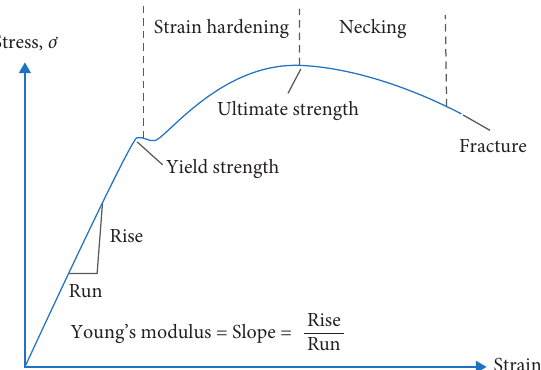
Figure 1: Typical low carbon steel stress-strain